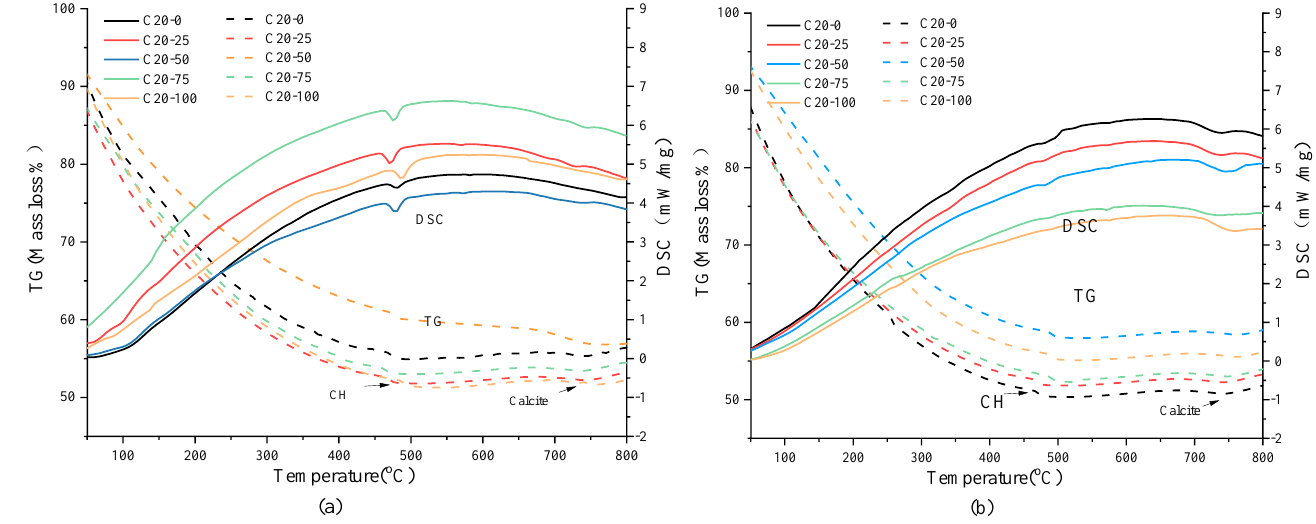
Figure 7. DTA analysis of concrete. ( a ): Curing ages(7 days); ( b ): Curing ages(28